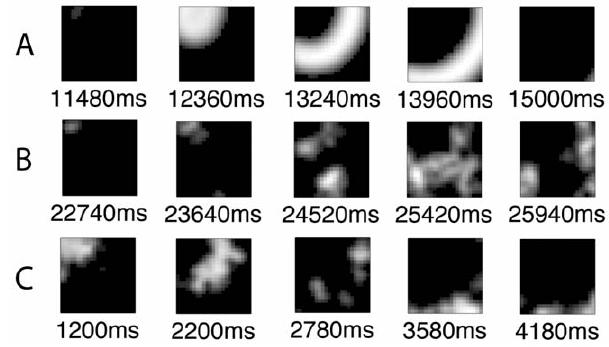
Figure 2. Depiction of a model wave generated using the parameters given in Table 1 (A) and through randomizing SAC refractory periods (B and C). Model RGCs are shown using an intensity plot where the brightness scales with the firing rate. The waves propagate in a radially symmetric pattern due to the isotropy of the SAC lateral weights, or model dendrites. Other geometries were achieved through randomizing B R by choosing B R from a normal distribution centered on .09 where s ~ : 3 (negative values were set to